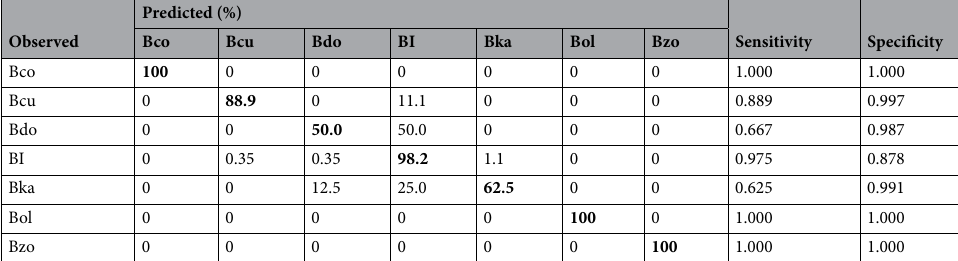
Table 3. Classification results for the ANN classifier on test dataset of morphometric measurements of Bactrocera spp., with observed species affiliation in the rows and predicted species allocation in the columns. Correct classification rate appears along the diagonal in bold. Bco— B. Correcta , Bcu— B . cucurbitae , Bdo— B. dorsalis , BI— B. invadens , Bka— B. kandiensis , Bol— B. oleae , Bzo— B.